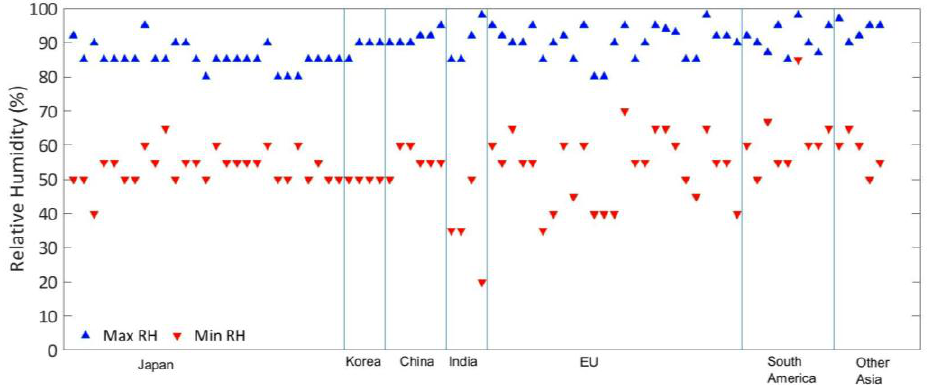
Figure 12. Maximum and minimum relative humidity around the world.